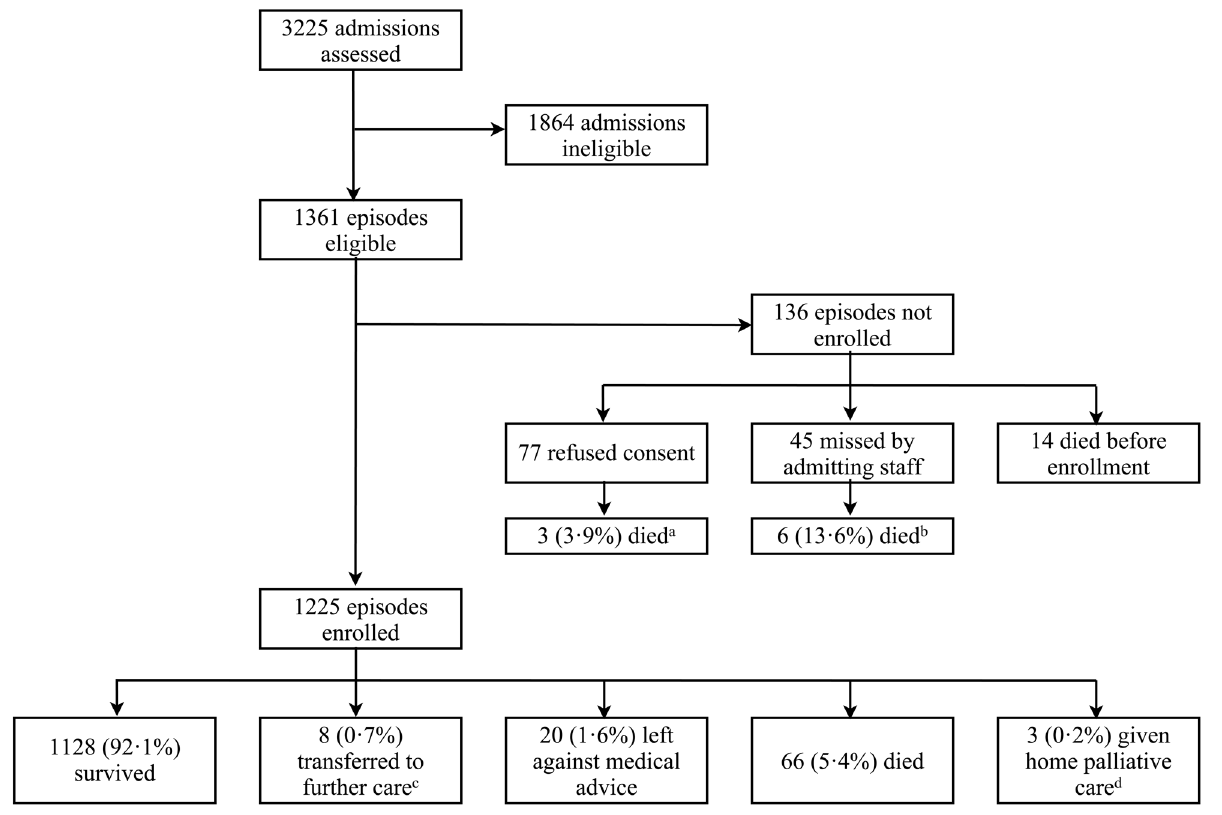
Figure 2. Flow chart showing enrolment to the study. Notes: a including one home palliative care; b including one home palliative care; c excluded from analyses of outcome (e.g. in odds ratios); d included as ‘‘died’’ in analyses.